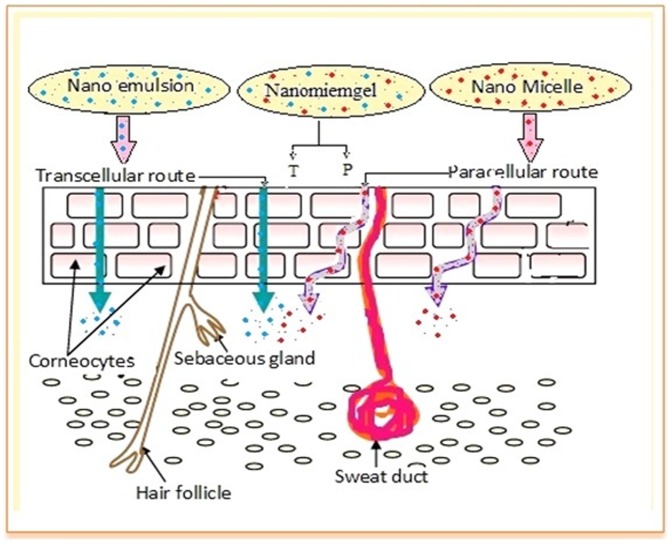
Graphical representation of nanomiemgel and its hypothetical paths of entry into the skin where T: Transcellular & P: Para cellular route of absorption.